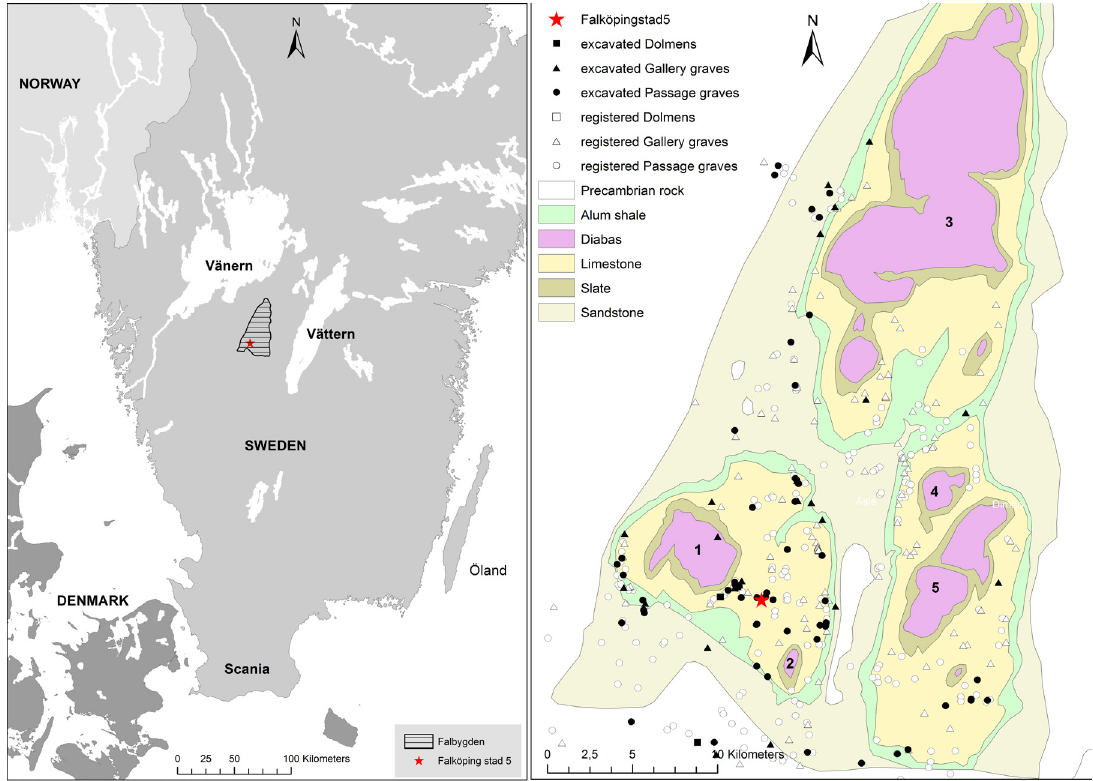
Figure 1. The location of Falbygden and Falköping stad 5. 1: Mösseberg, 2: Ålleberg, 3: Billingen , 4: Varvsberget, 5: